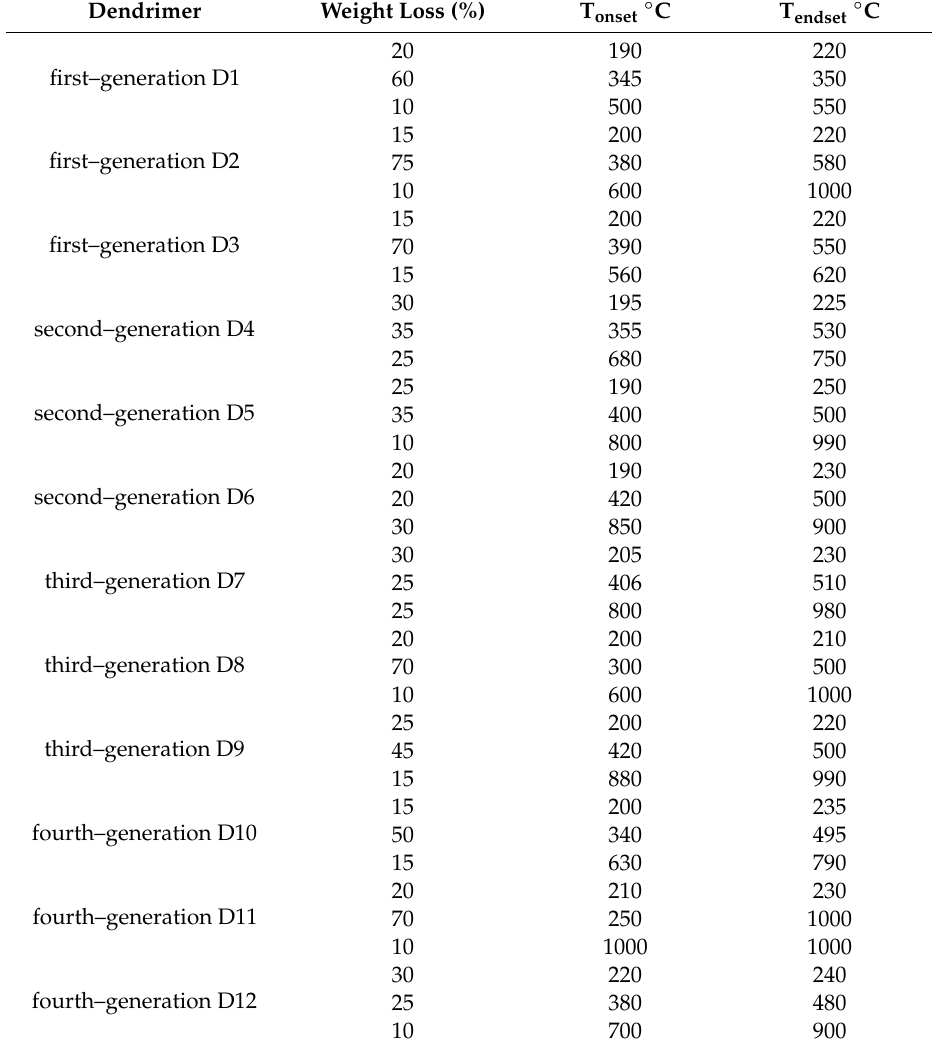
Figure 3. Thermogravimetric analysis (TGA) of generation first-generation D2, second-generation D5, third-generation D8, and fourth-generation D11. Table 2. Thermal analysis of dendrimers 1–12